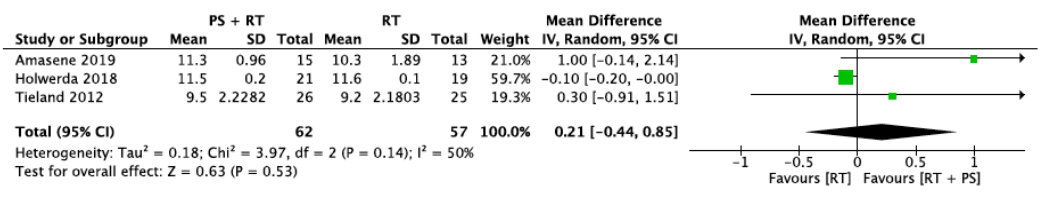
Figure 8. Impact of RT + PS on Short Physical Performance Battery (SPPB).